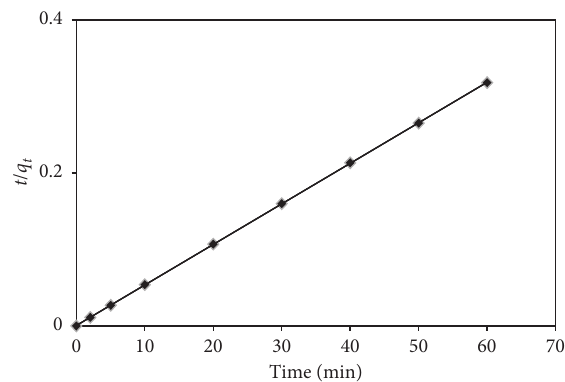
Figure 11: Crystal violet adsorption model for pseudo-second- order kinetic.